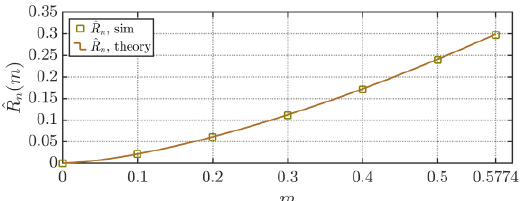
Figure 31. Normalized neutral current ripple rms as a function of m .